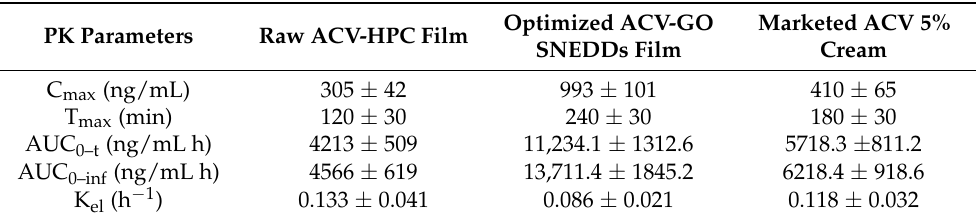
Table 4. Comparative pharmacokinetic parameters of different ACV film formulations and marketed cream (mean ± SD, n = 6).